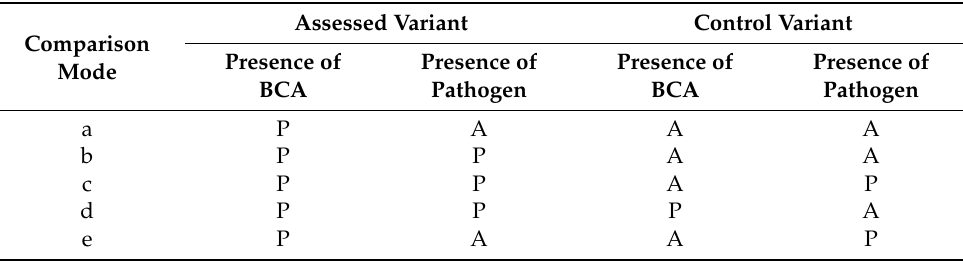
Table 2. The arrangement of five comparisons of strawberry plants of different variants of the experiment combining the presence and absence of BCAs and P. cactorum